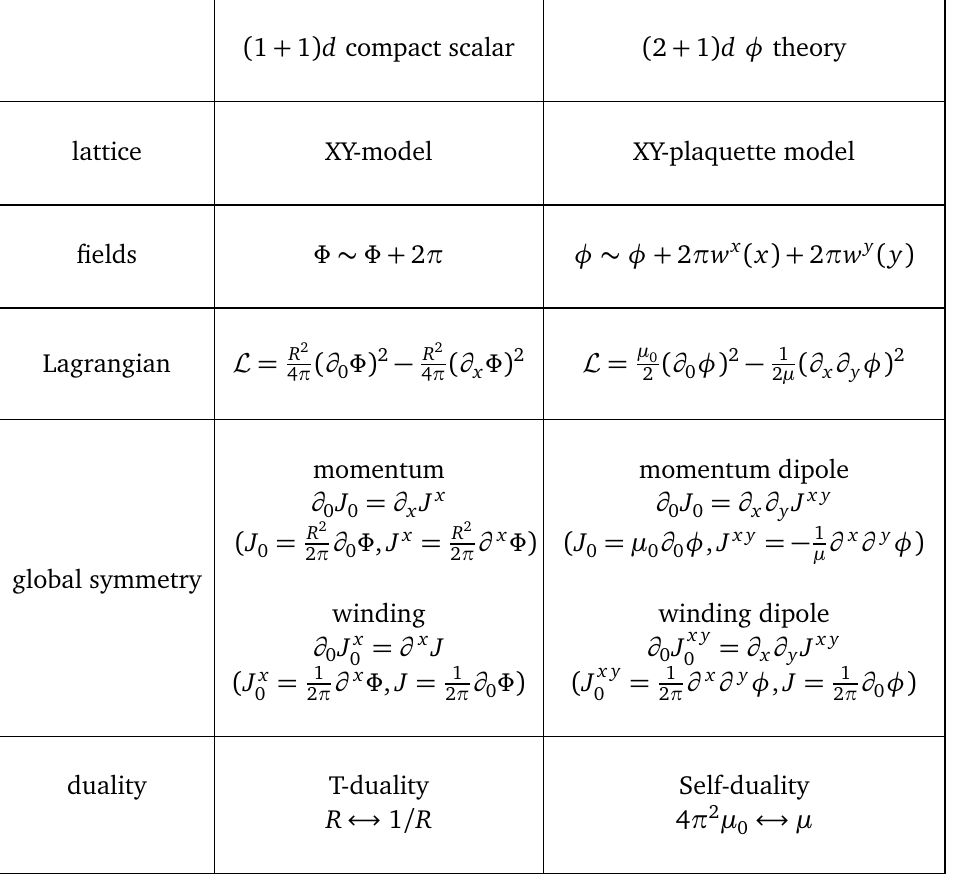
Table 2: Analogy between the ordinary 1 + 1-dimensional compact scalar theory and the 2 + 1-dimensional φ -theory. Detailed explanations will be given in the body of the